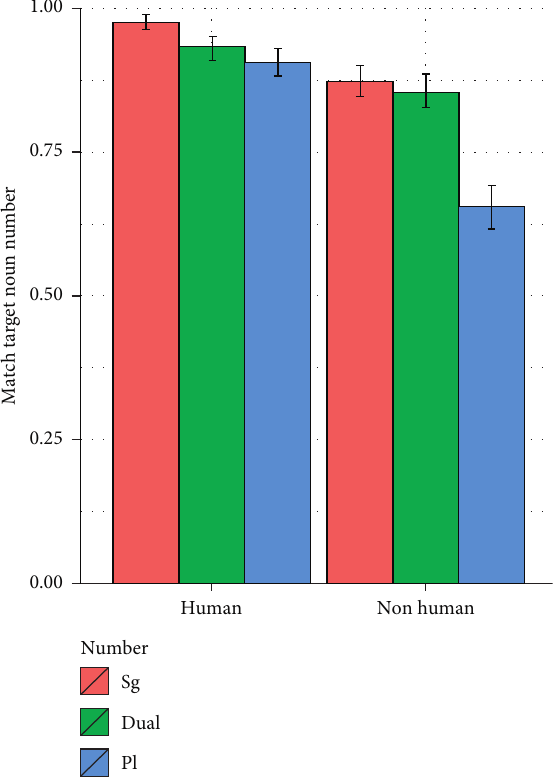
Figure 8: Correct mean % on noun inflection by number and animacy for LP.